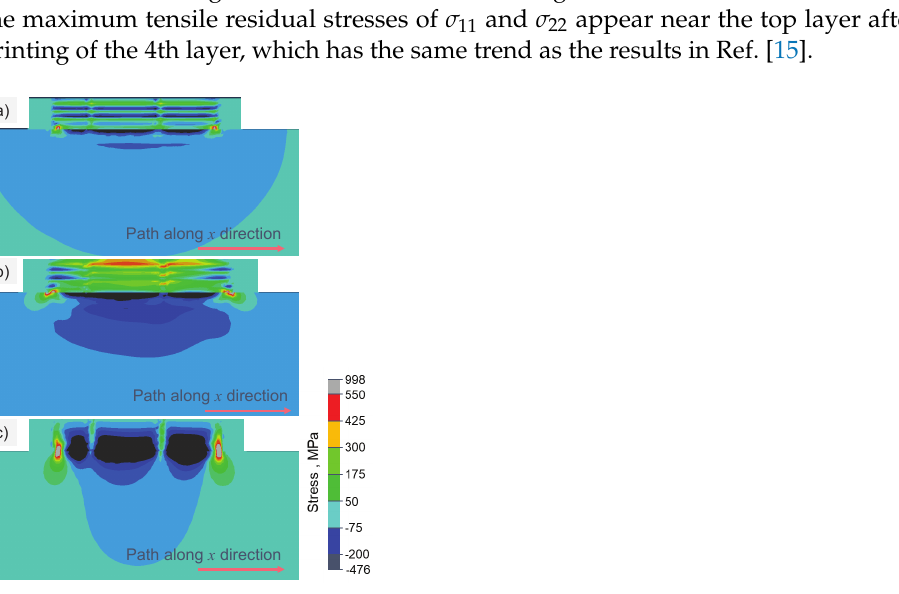
Figure 9. Longitudinal strain field at the end of depositing. ( a ) σ 11 , ( b ) σ 22 and ( c ) σ 33 in the 4th layer of Ti6Al4V powder on substrate. Laser beam scanning direction is along the positive x